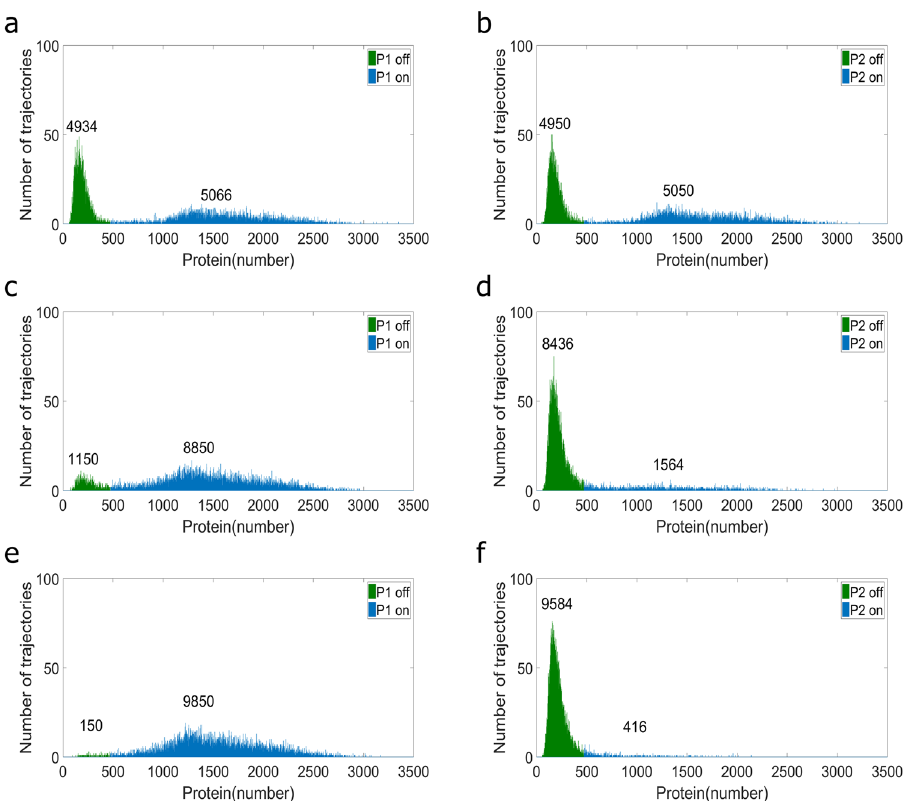
Figure 4. The bimodal distribution under the circumstance with the assumption that the only consumption of complexes X and Y comes from dissociation. There is no shift of the deterministic steady state and the change of stationary distribution results from altering the stochasticity. The transcription rate of gene Y is of the nominal value. ( a ) and ( b ) are bimodal distributions of P1 and P2 monomers with the transcription rate of gene X of the nominal value. ( c ) and ( d ) are with the transcription rate of gene X adjusted to 8 folds of the nominal value. Peptide X instructed cells to the ON state of P1 through the change of stochasticity. ( e ) and ( f ) are bimodal distributions with the transcription rate of gene X adjusted to 16 folds of the nominal value. Most of the cells were guided to the ON state of P1 by the change of intracellular